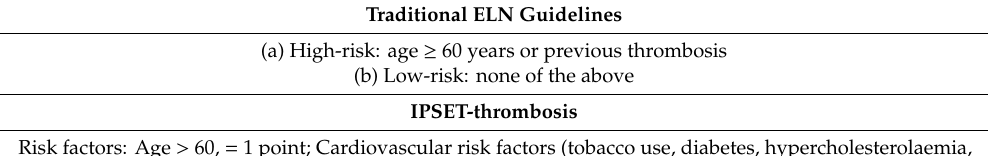
Table 2. Evolution of prognostication systems in essential